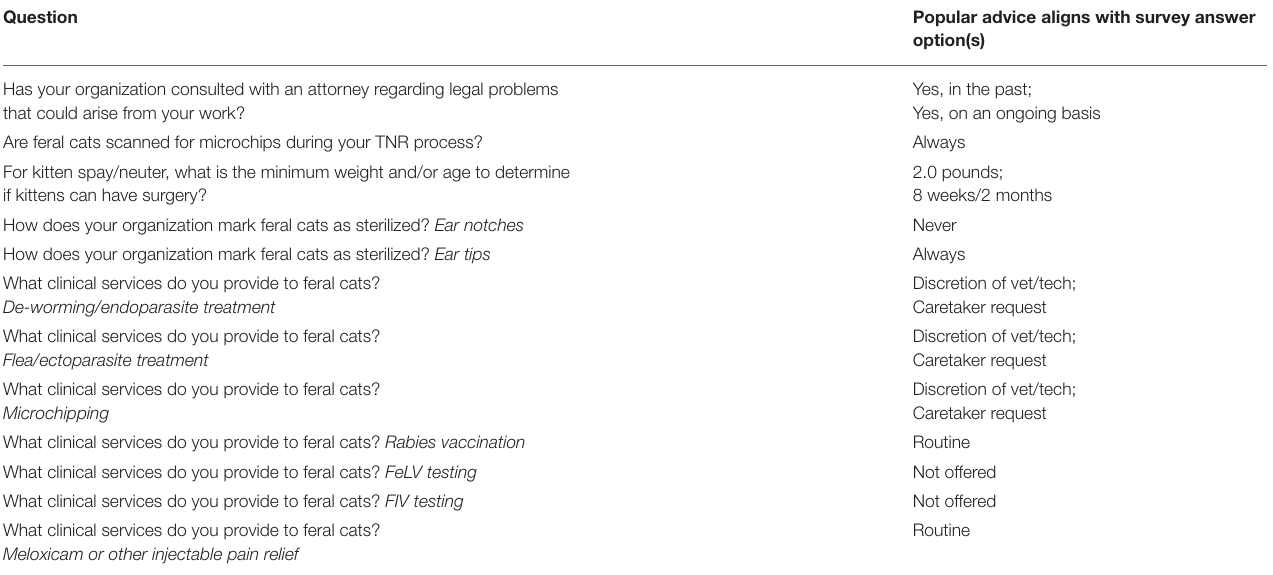
TABLE 1 | Twelve questions used in the creation of our best practice adherence model. Question